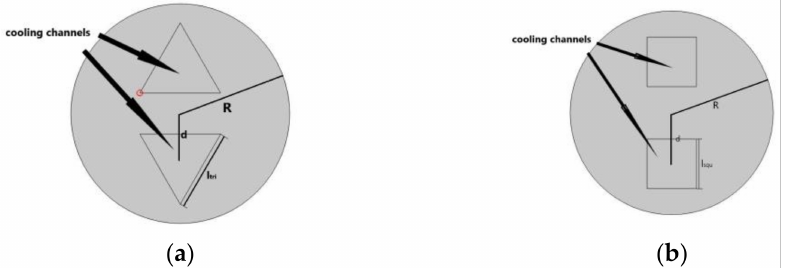
Figure 1. The schematics of two circular sections. Wherein, subfigure ( a ) is a triangle section channel model, and subfigure ( b ) is a square section channel model. The red circle is to emphasize that the angle of the liquid cooling channel is a small arc connection to reduce the